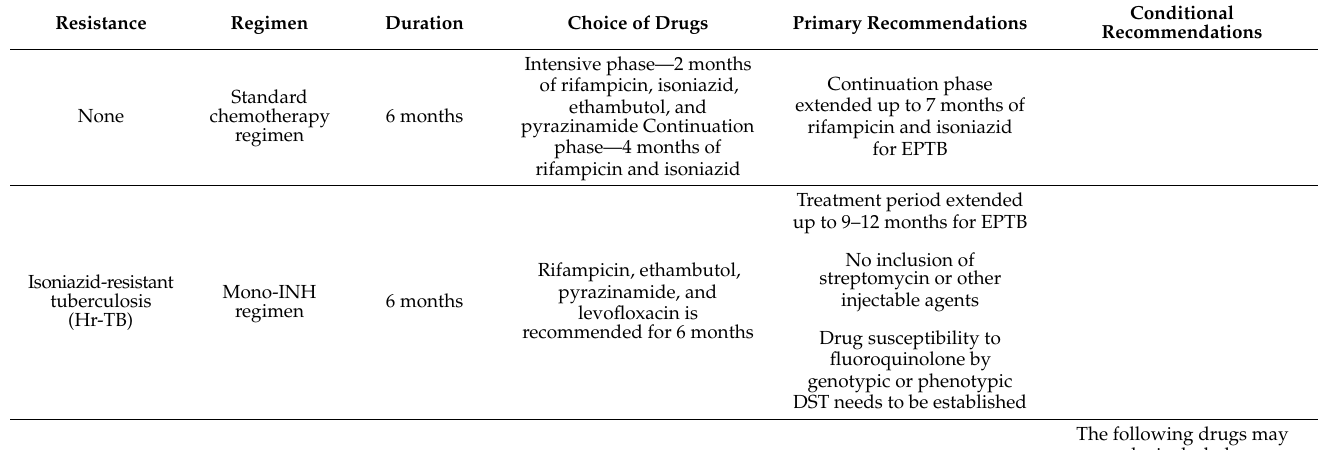
Table 3. Summary of the WHO guidelines for drug-sensitive and DR EPTB treatment $